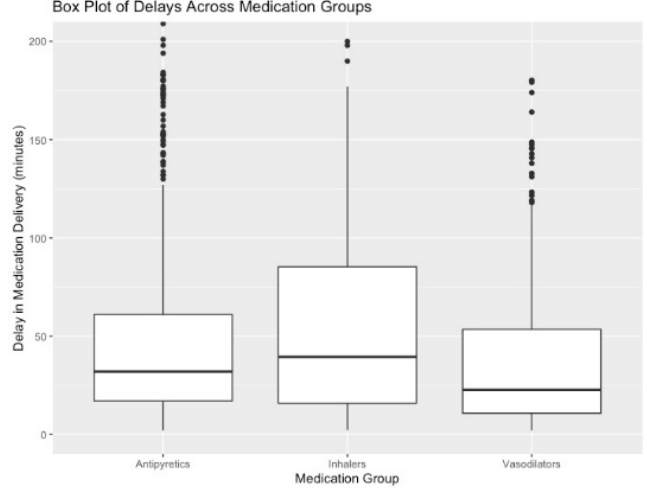
Figure 2. Box plots showing the distribution of observed delays across medication groups. The box plot shows the median and quartiles of observed delays (in minutes) of antipyretics, inhalers, and vasodilators. The mean delays (standard deviation) for these three groups are: 61.3 min (114 min) for antipyretics, 73.8 min (133 min) for inhalers, and 45.1 min (72 min) for vasodilators. This figure is truncated for clarity; the y-axis is truncated to show delays between 0 and 200 min. Table 4 . Table of first-stage regression results for medication delays in antipyretics, inhalers, and vasodilators .